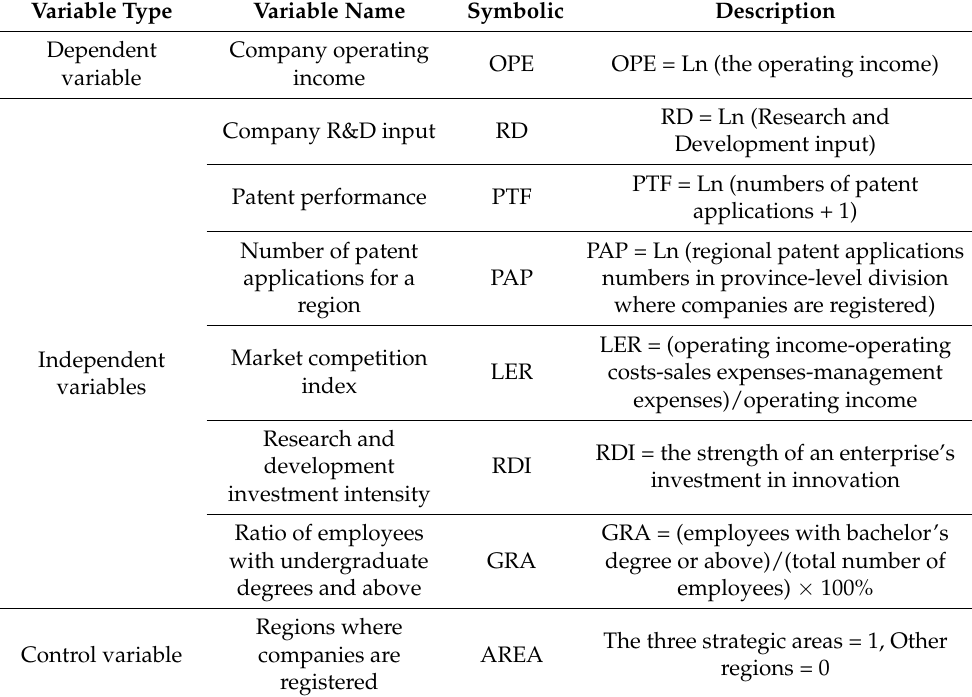
Table 1. System of indicators for